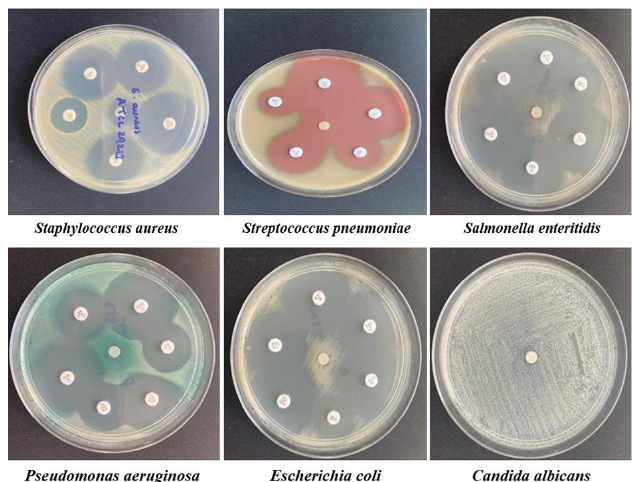
Figure 4 . Essential oil antibacterial activity against bacterial and fungal strain